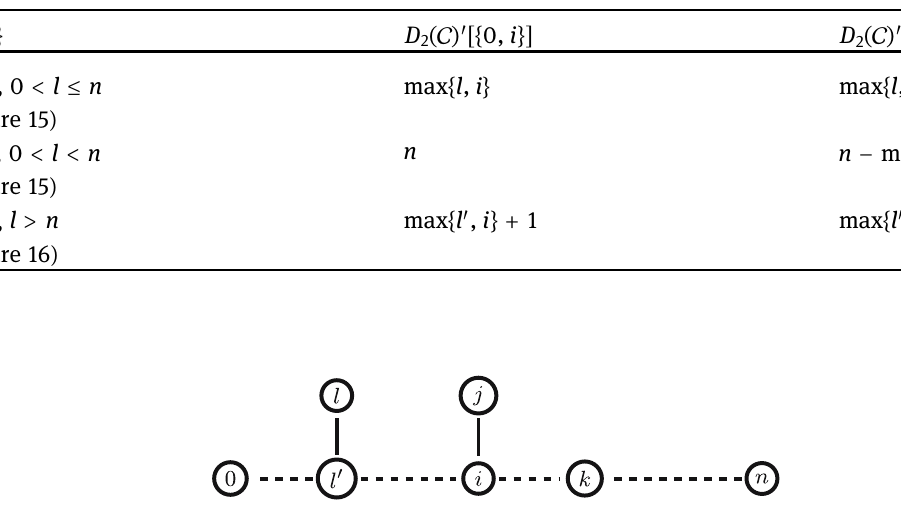
Figure 16: Minimum subgraph of C containing vertices